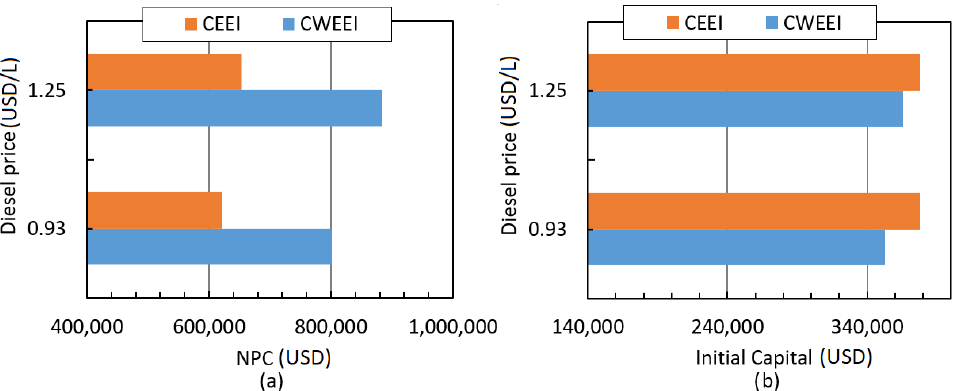
Figure 11. Costs of the CEEI and the CWEEI for diesel generator/SPVS/BESS configuration, ( a ) NPCs, and ( b ) initial